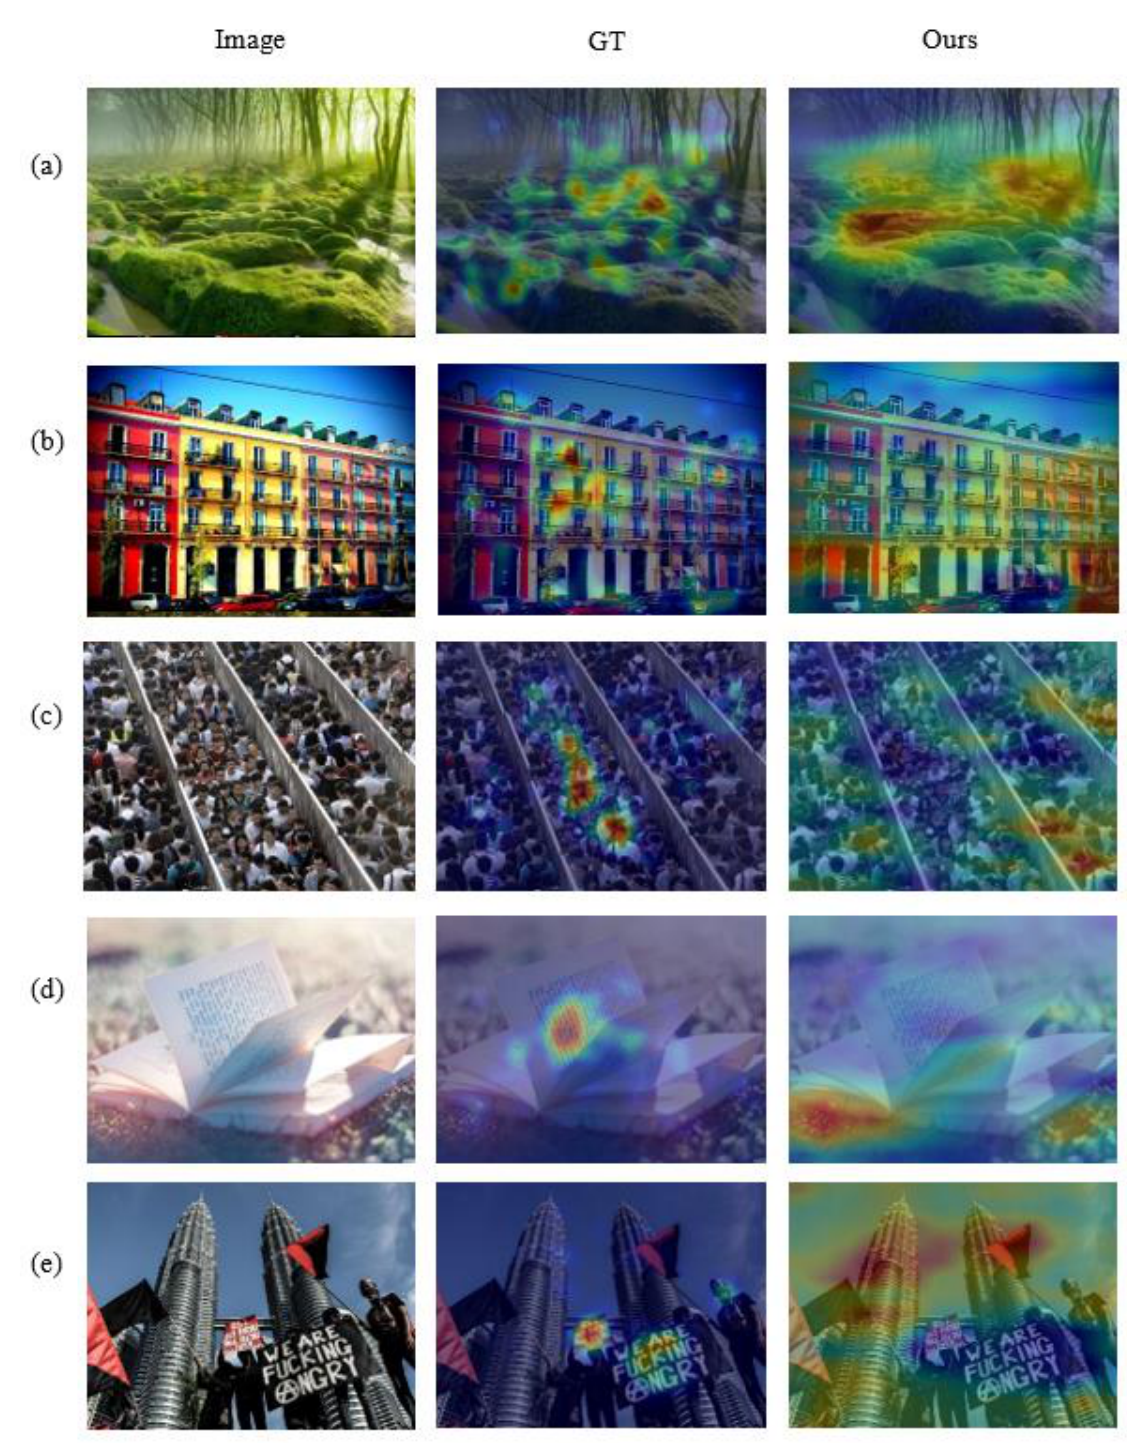
Figure 13. Some typical examples of failures on the EMod dataset. GT is the ground truth. For example, there are no prominent semantic objects in ( a , b ), and ( c ) exemplifies that when there are a large number of similar objects in the scene (people in this example), the visualization of the model in these examples is terrible. Human-specific factors are also difficult for the model. For example, the viewer can understand the text information in ( d , e ), but the model does not work.